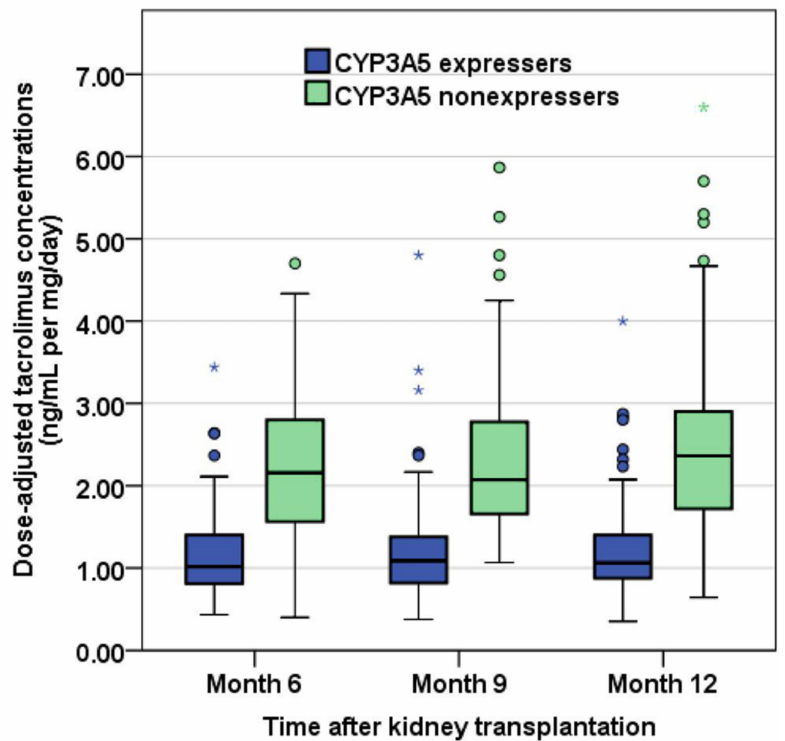
Figure 3. Box plots of dose-adjusted tacrolimus trough concentrations in CYP3A5 expressers and nonexpressers at months 6, 9, and 12 post-kidney transplantation (the circle is the value that exceeds the first quartile minus 1.5 times the interquartile range or the third quartile plus 1.5 times the interquartile range; the asterisk represents the value that exceeds the first quartile minus 3.0 times the interquartile range or the third quartile plus 3.0 times the interquartile range).